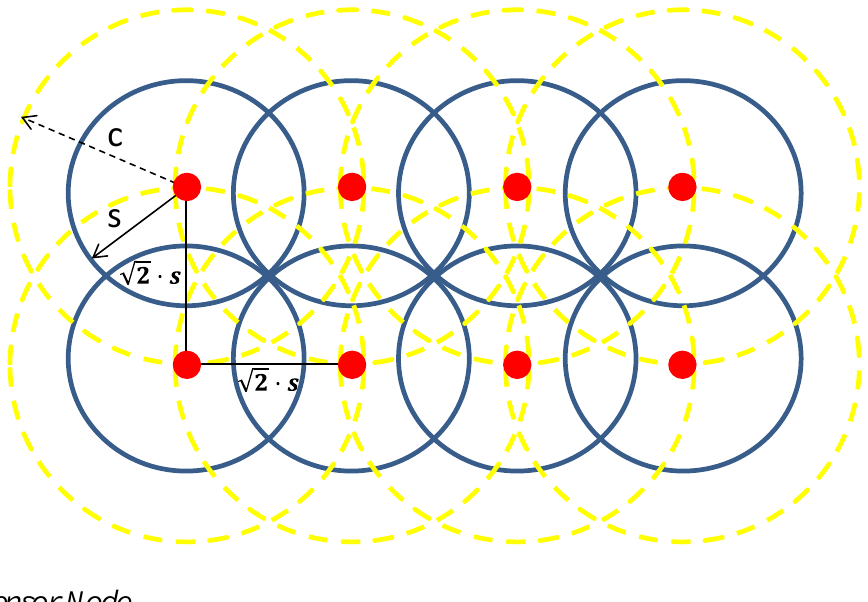
Figure 4. Sensing coverage of a wireless sensor